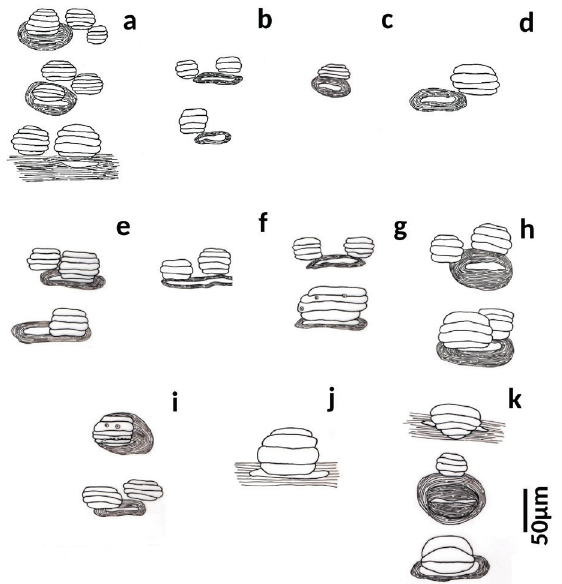
Figure 4 - Number and arrangement of mamelon-like structures to the vulva of A. hylambatis from different amphibian hosts and localities in Argentina. (a) L. bufonius from